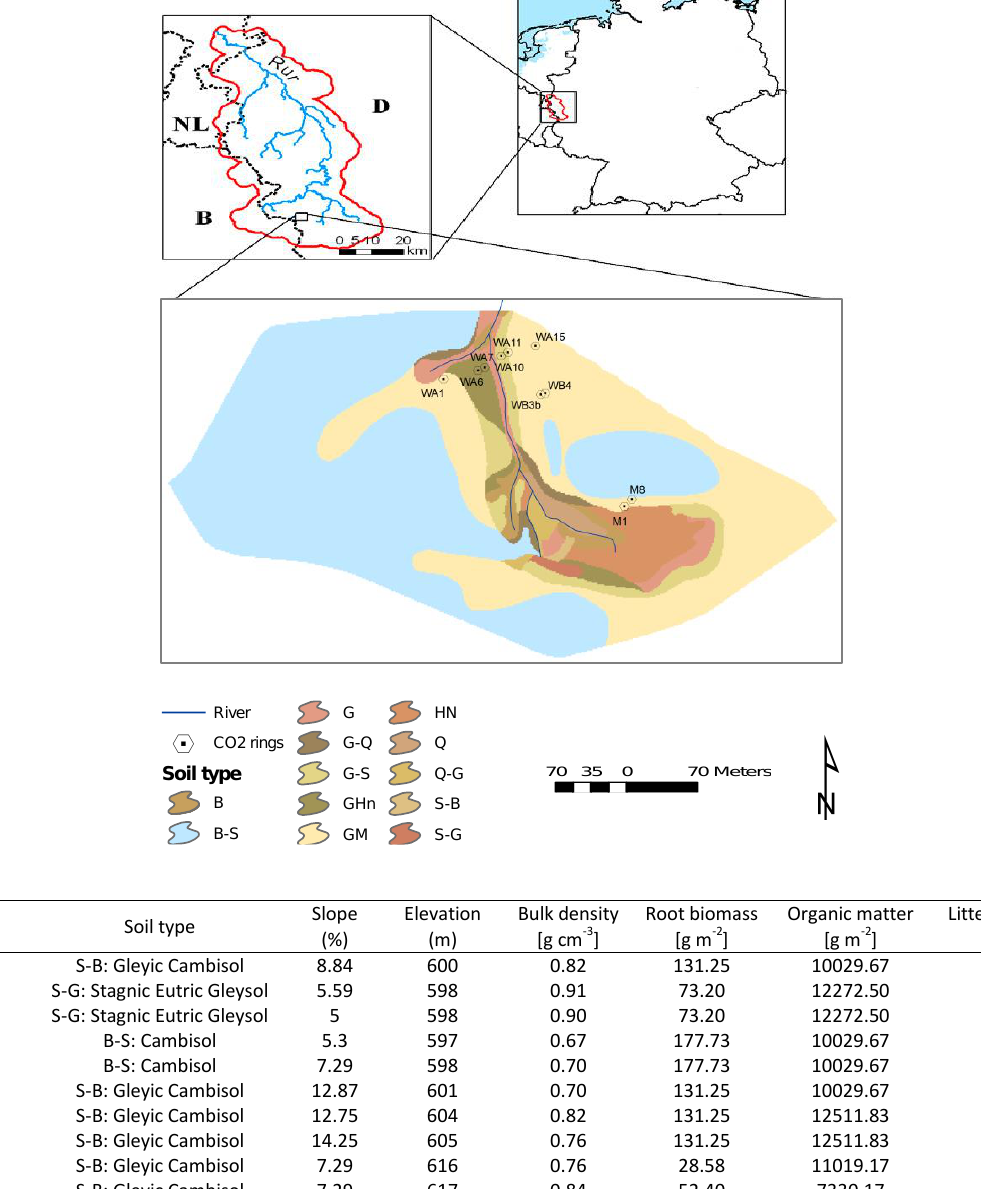
Figure 1. Location of the measurement sites (M1, M8, WA1, WA6, WA7, WA10, WA11, WA15, WB3b, WB4) in the Wüstebach catchment, Germany, as used in this study (modified from Sciuto and Diekkrüger, 2010).